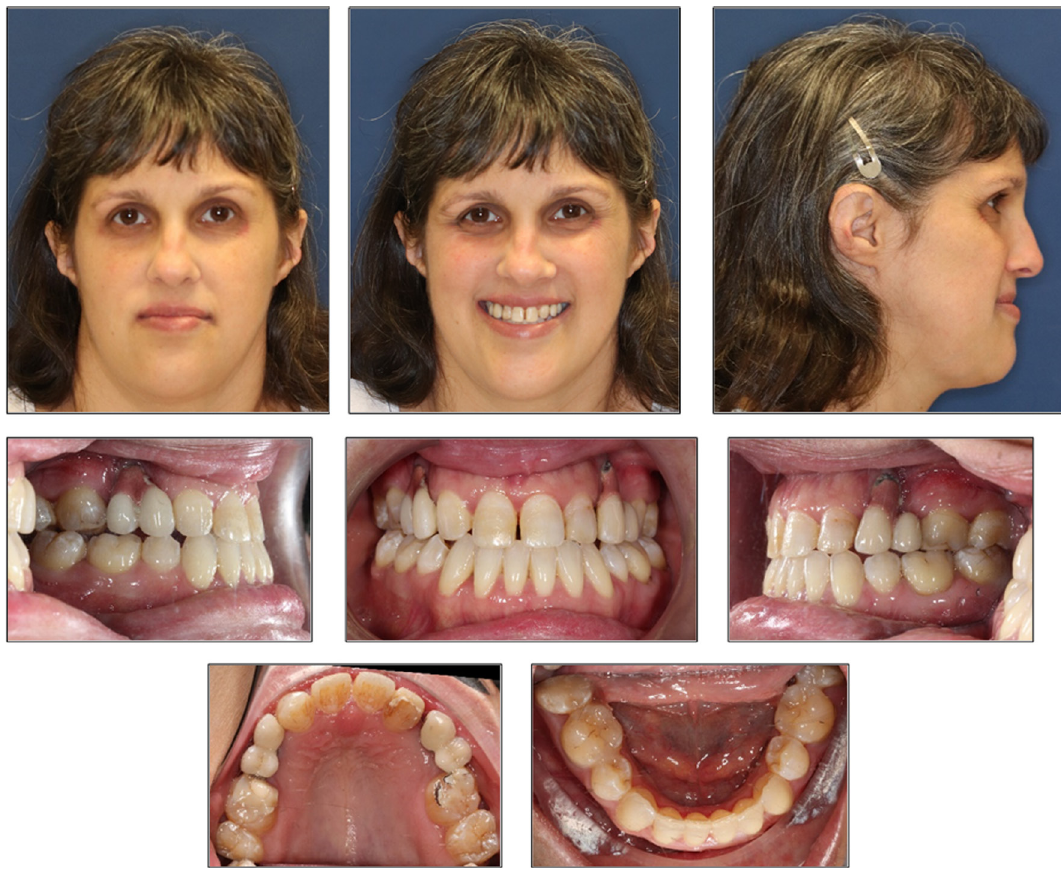
Figure 9. Twenty-four years post-FM cessation